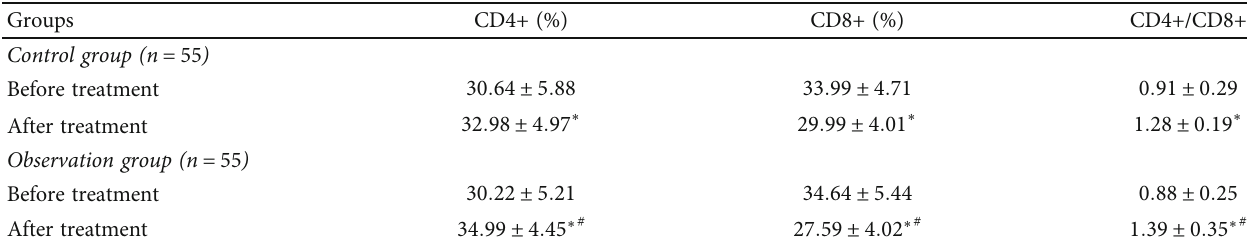
Table 6: Percentage of T-lymphocyte subpopulations before and after treatment in both groups.